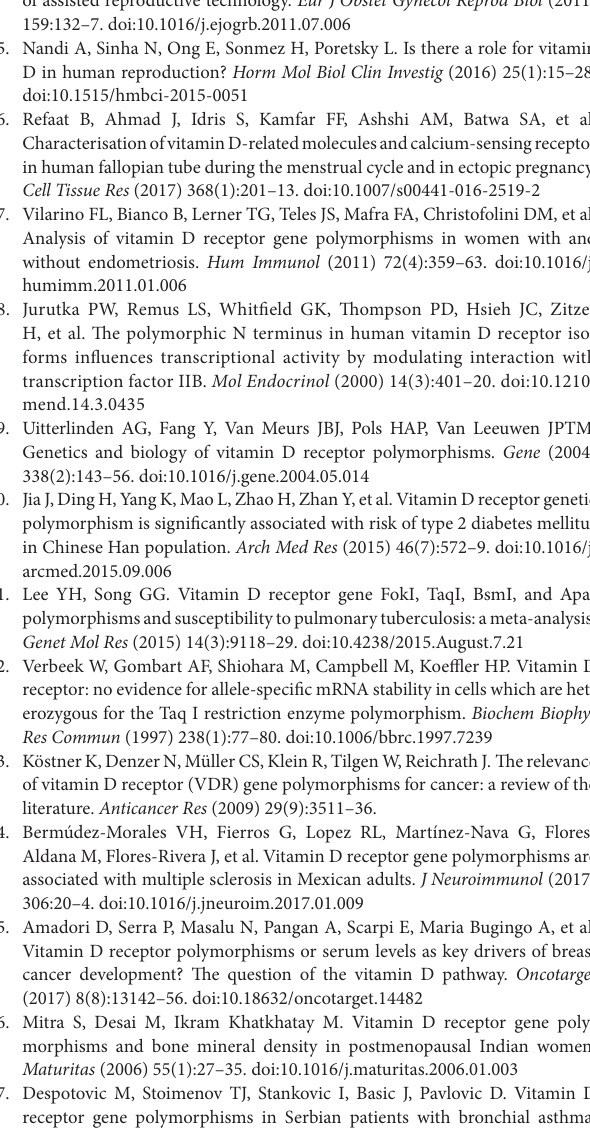
indicating the TC (heterozygous) genotype. Lane 2 contains an uncut band with a length of 495 bp. Lane 7 contains two bands at 290 and 205 bp, indicating the CC (homozygous) genotype. FigUre s2 | Agarose gel electrophoresis of DNA against a 100-bp DNA ladder (Promega) following PCR amplification and restriction fragment length polymorphism with the BseGI restriction enzyme. (a) Lane 1 contains an uncut band at 265 bp. Lane 2 contains fragments at 265 bp, indicating the TT (homozygous) genotype. Lane 3 contains two bands at 196 and 69 bp, indicating the CC (homozygous) genotype. (B) Lane 1 contains an uncut band with a length of 265 bp. Lanes 2 and 3 contains fragments at 265 bp, indicating an uncut fragment and, therefore, the TT (homozygous) genotype. FigUre s3 | DNA fragment sequences in affected and unaffected individuals. The BamH1 restriction site sequence is underlined, and the arrows indicate the polymorphic site. (a) DNA sequence electropherogram of the wild-type G/G genotype (arrow). (B) DNA sequence electropherogram of the homozygous A/A polymorphism (arrow). (c) DNA sequence electropherogram of the heterozygous G/A polymorphism